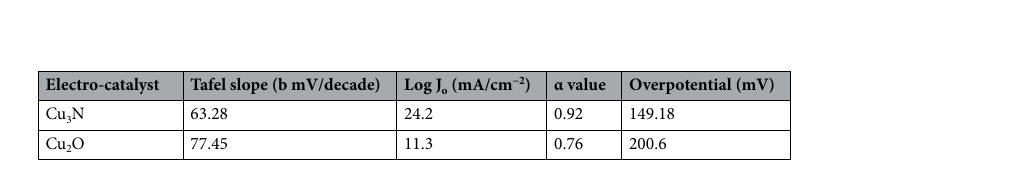
Table 2. Tafel slope and exchange current density for HER with Cu 3 N electrode.